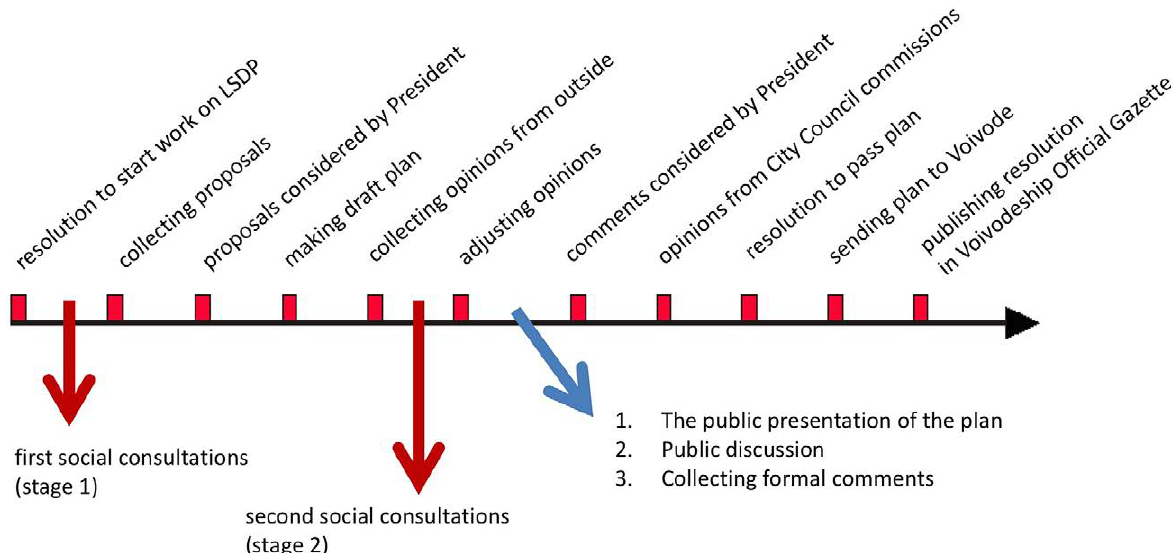
Fig. 1. Preparation of local spatial development plans (LSDP) in Poznań, with stages of statutory and non- statutory public consultations. Source: own